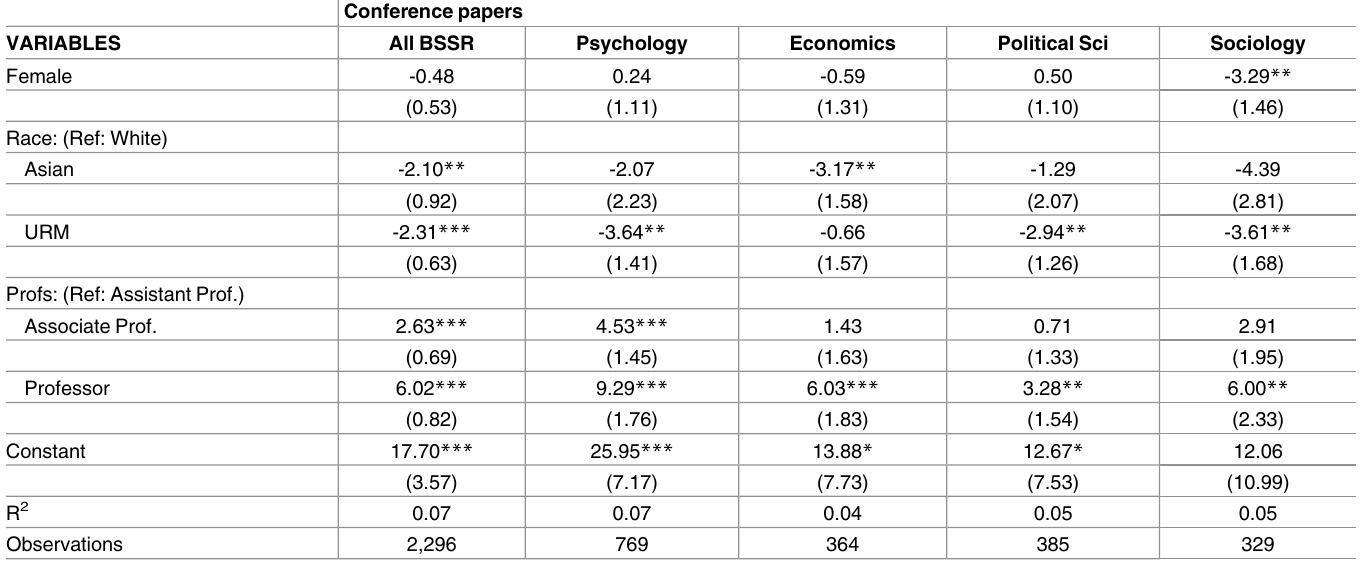
Table 8. Associations between demographic variables and conference papers among BSSR scientists employed in tenure-track or tenured